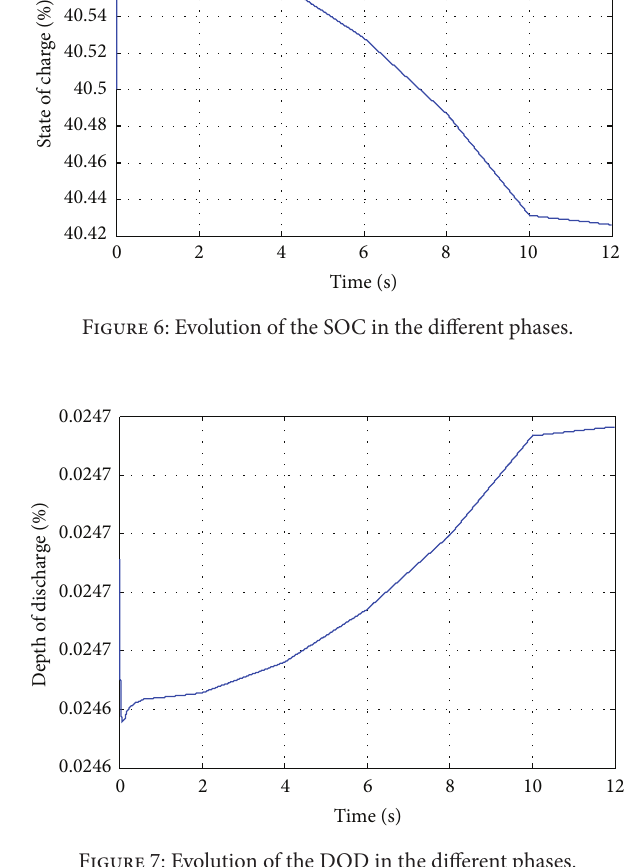
Figure 7: Evolution of the DOD in the different